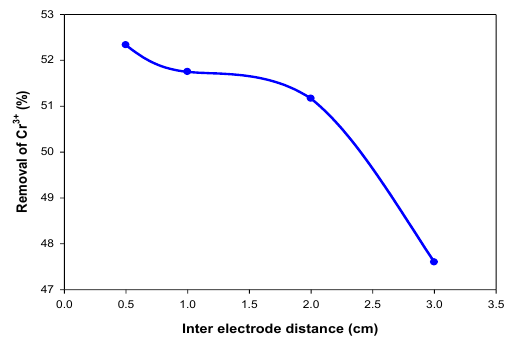
Fig. 4. Effect of inter electrode distance on the Cr 3+ re- moval. Current density 9.34mA/cm 2 , initial Cr 3+ concentra- tion 1000mg/L, time 20 minute, pH